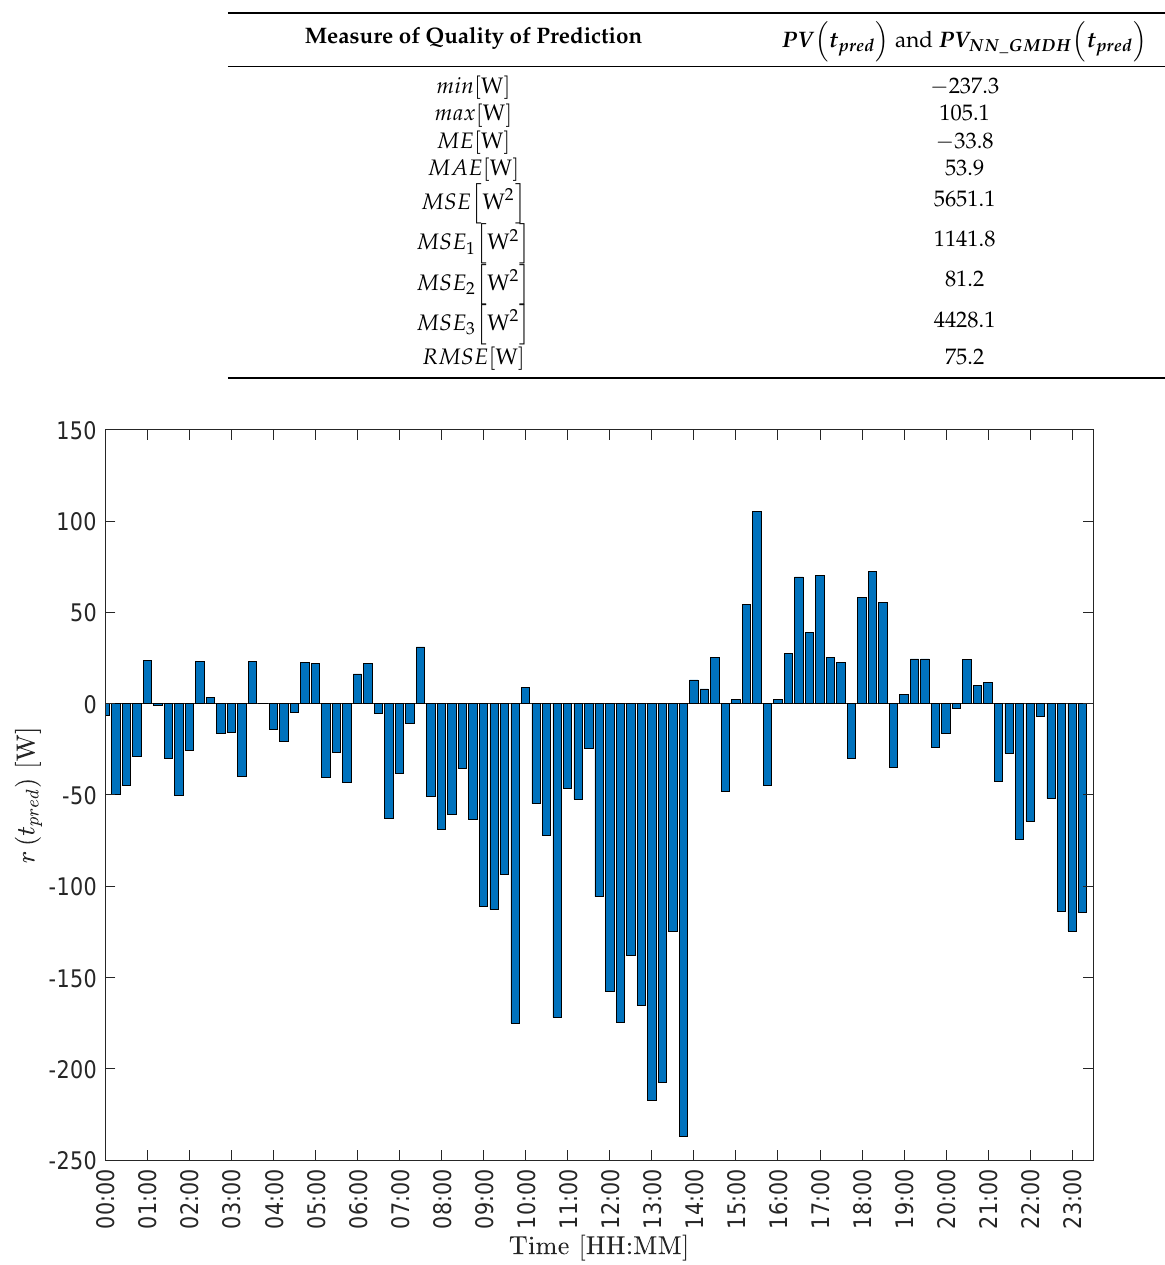
(cid:16) (cid:17) t pred and PV NN _ GMDH